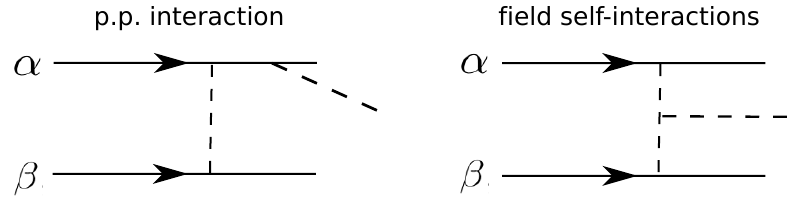
Figure 3 . Interactions contributing to the current at O (2). The scalar (cid:12)eld theory for the right- hand side graph has cubic self-interactions. If this were not the case, such graph would not con- tribute to J j . The solid lines are the worldlines of the point-particles (which can carry color O (2) charge degrees of freedom depending on the theory under consideration) and the dashed lines rep- resent the scalar